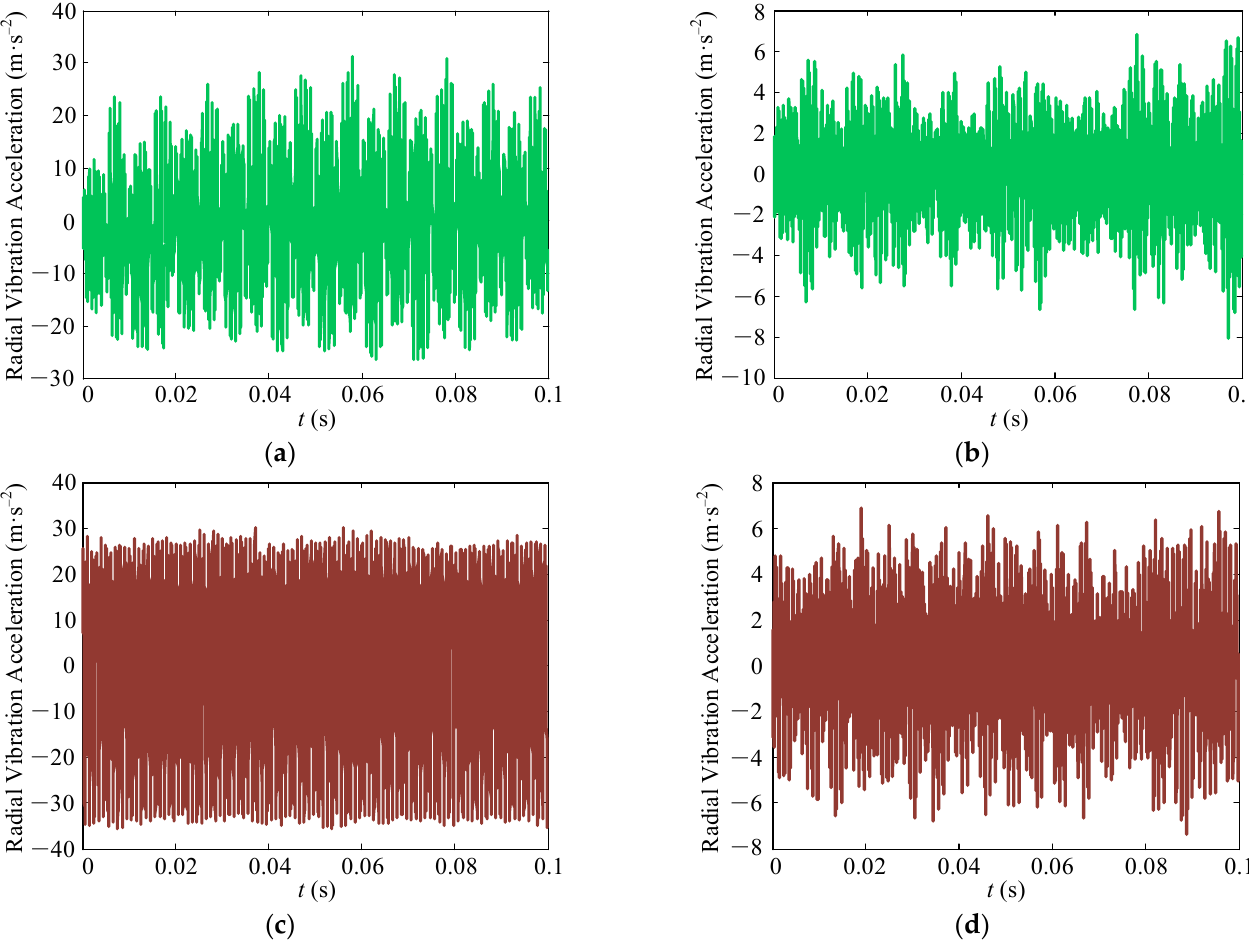
Figure 10. Vibration response of DGB 6205 system under time-varying load and constant load: ( a ) X -direction vibration response under time-varying load, ( b ) Y -direction vibration response under time-varying load, ( c ) X -direction vibration response under constant load, and ( d ) Y -direction vibration response under constant load.